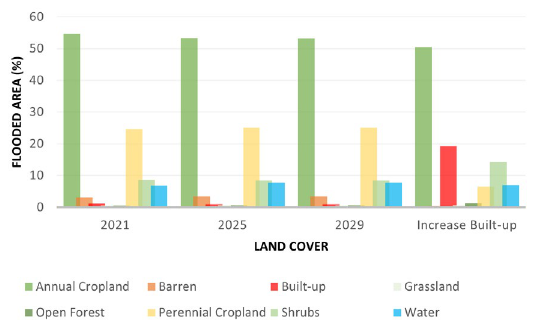
Figure 16. Flooded areas for each land cover with a 25-year rainfall return period.